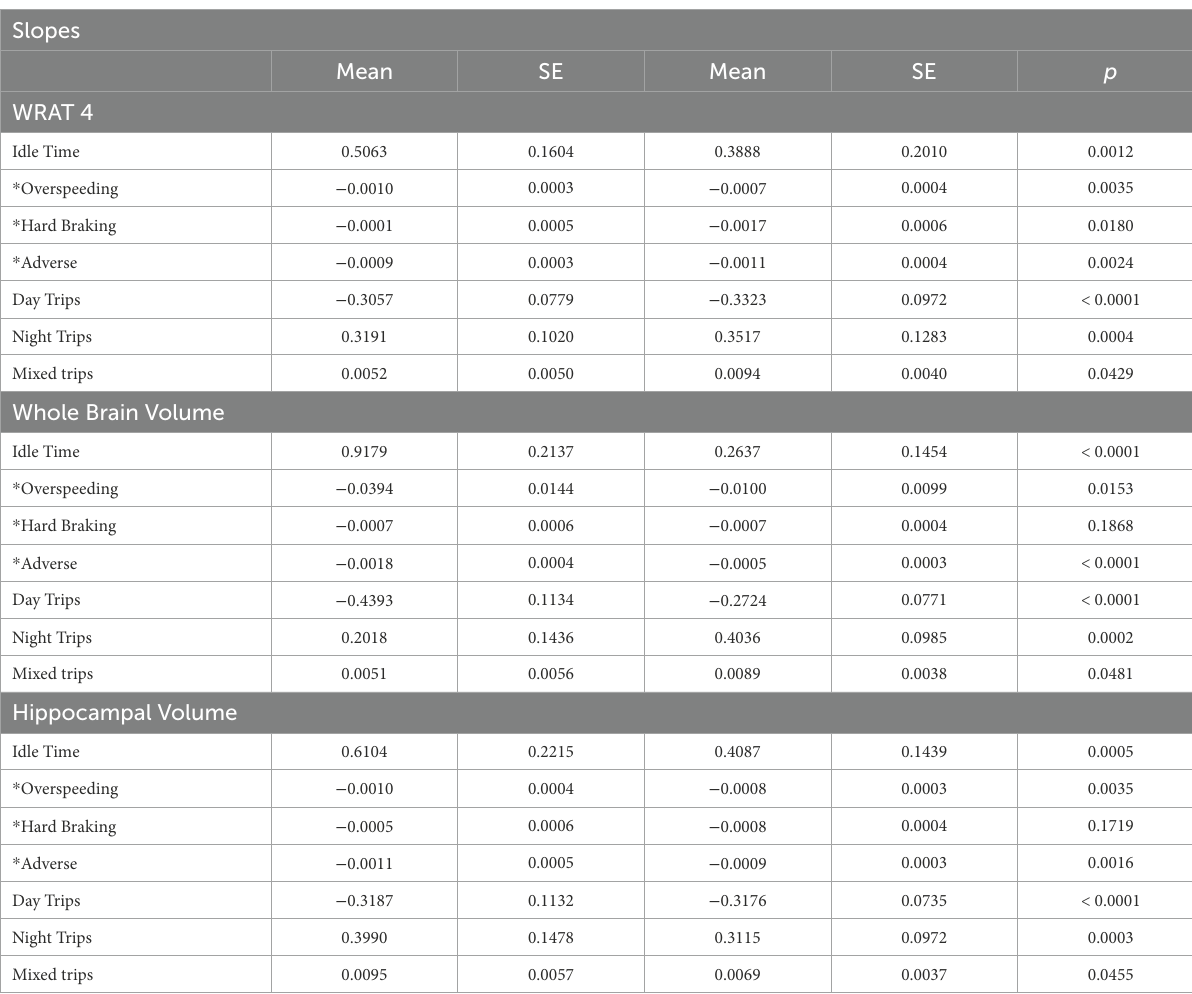
TABLE 2 Change over time as predicted by slopes of daily driving outcomes by three